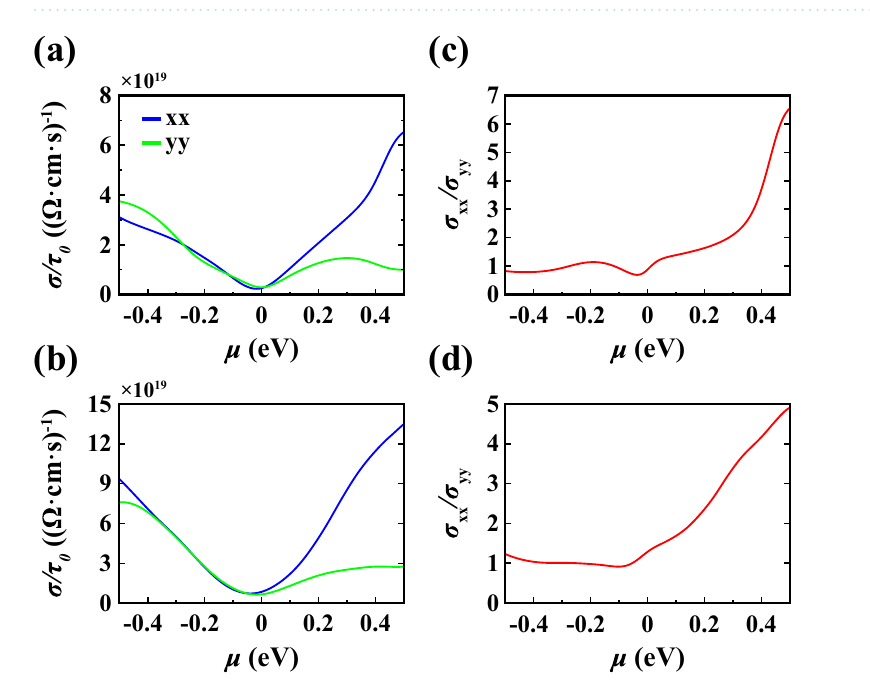
Figure 4. Seebeck coefficient ( S ) calculated as a function of chemical potential ( µ ) at various temperatures and as a function of temperature ( T ) at various chemical potentials for ( a ) 1L and ( b ) 4L 1T ′ WTe 2 along both xx and yy lattice directions.